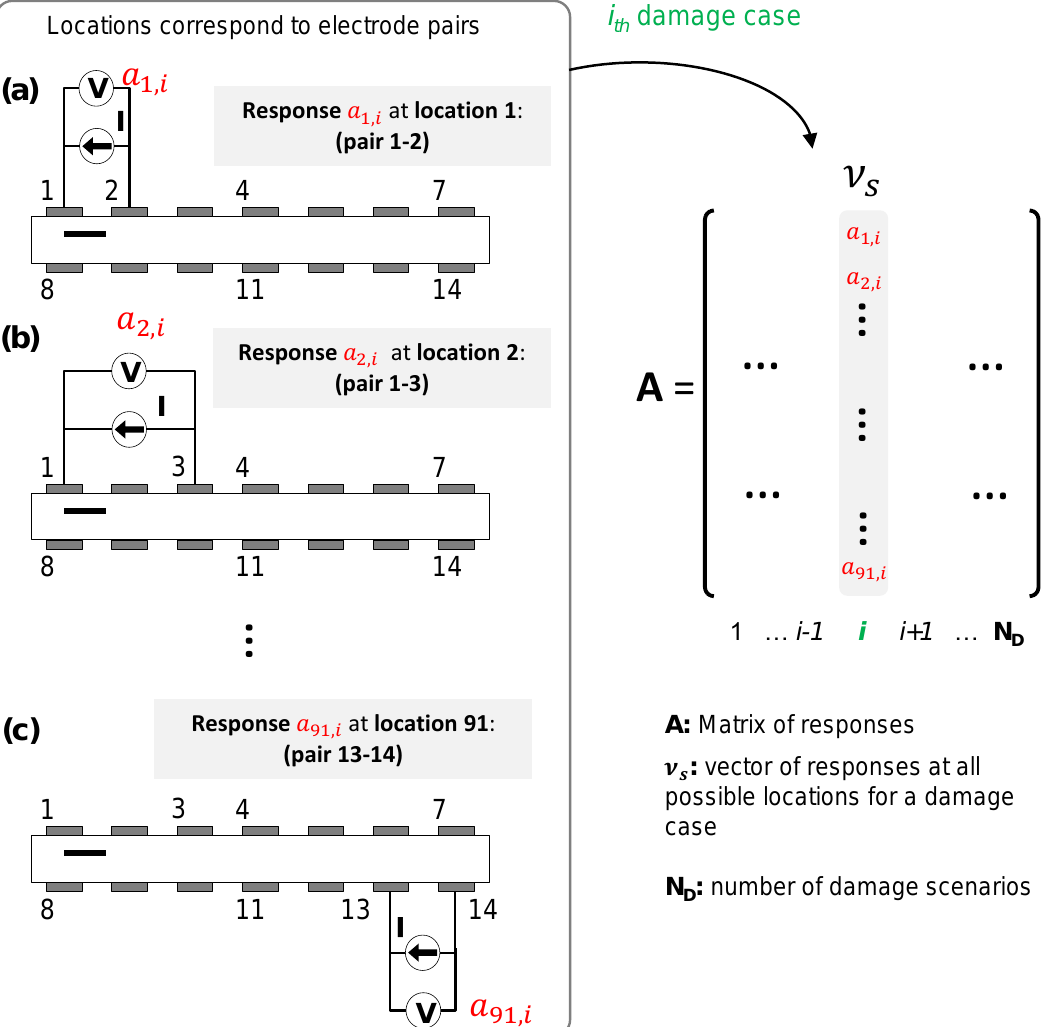
Figure 2. Scheme used for damage identification using two-probe schemes and two-sided electrodes. The matrix of observations A is obtained from the responses in order to apply effective independence. Responses are grouped by damage scenario in column vectors ( ν s ) in matrix A : ( a ) starting with the response for consecutive electrodes on the left edge at the top surface; ( b ) following with increase of electrode distance and ( c ) finishing with the electrode pair on the right edge at the bottom